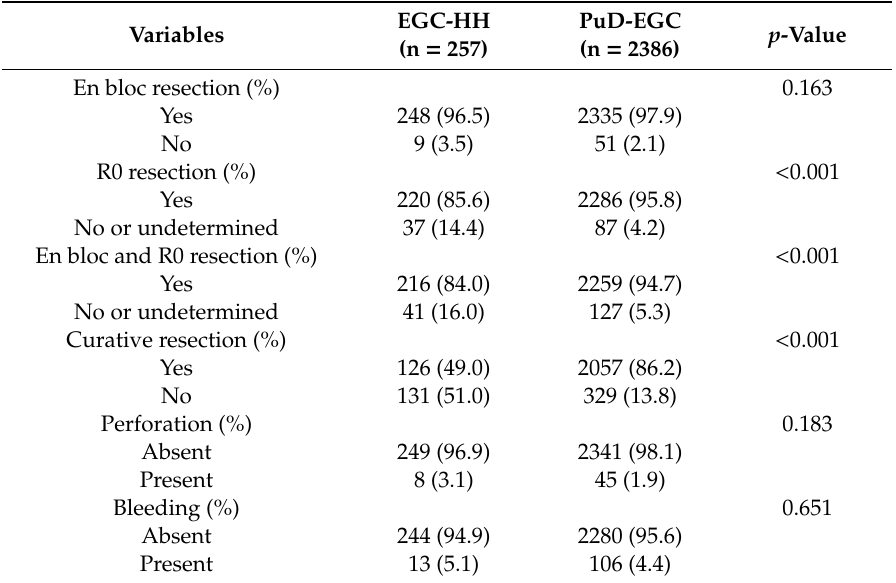
Table 2. Comparison of short-term outcomes of endoscopic submucosal dissection of di ff erentiated-type early gastric cancers with and without histological heterogeneity.